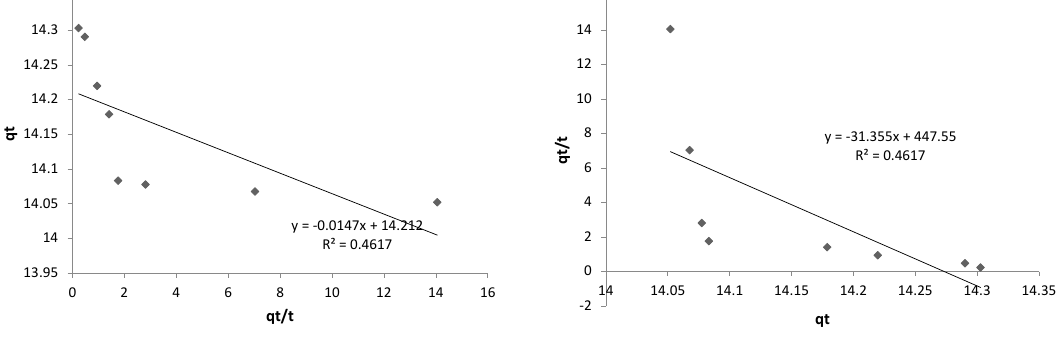
Fig. 7(c). Pseudo-second-order plot of Amido Black 10B adsorption onto Polyaniline nano-adsorbent (type 3) Fig. 7(d). Pseudo-second-order plot of Amido Black 10B adsorption onto Polyaniline nano-adsorbent (type 4)